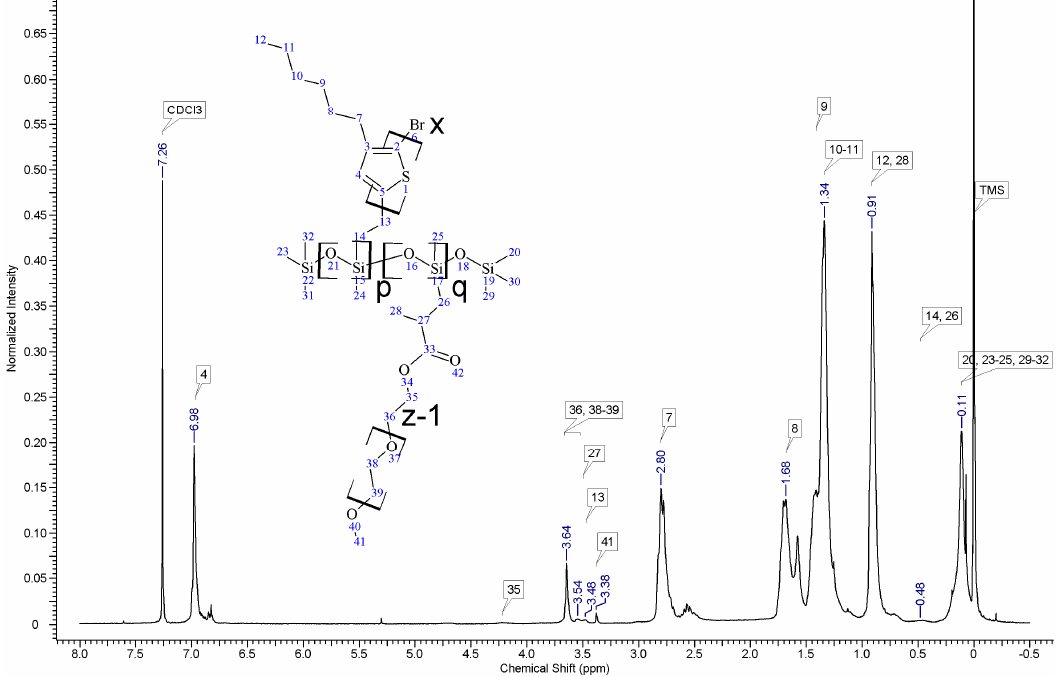
Figure A3. spectrum of poly(methylhydrosiloxane)-graft-[poly(3-hexylthiophene); poly(ethylene glycol)] (composed of hexane fraction of vinyl terminated poly(3-hexylthiophene),poly(methylhydrosiloxane) average M n ≈ 390; hexane fraction of graft copolymer) ( P3HT-Sil-PEG1 ).